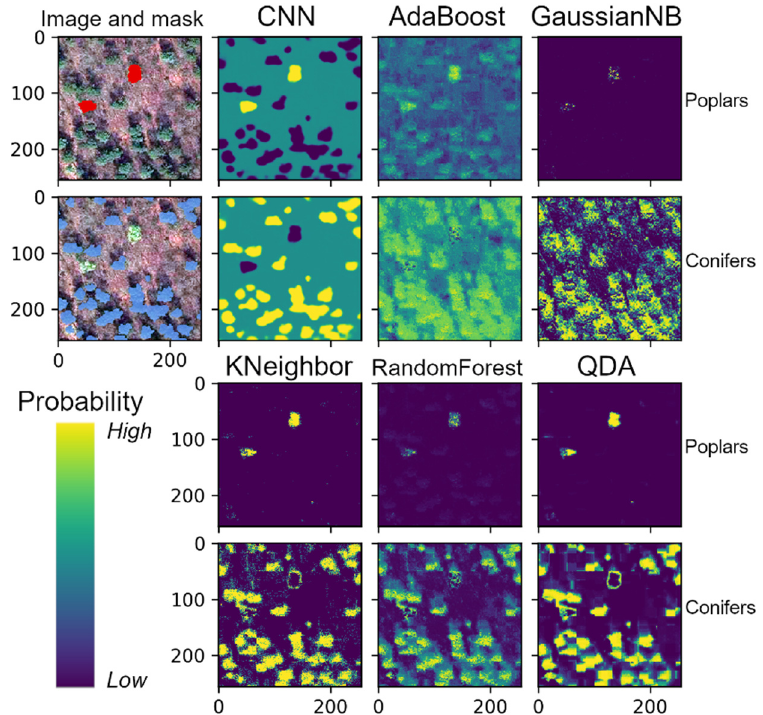
Figure 3. Comparison of pixel-based and U-Net-like CNN algorithm recognition results for 256 × 256-pixel images. The red color patches in the left images (Image and mask group) indicate masks for poplars, and the blue color patches indicate masks for coniferous trees. Segmentation algorithms: CNN—U-Net-like CNN; AdaBoost—adaptive boosting classifier; GaussianNB—naive Bayes classifier; RandomForest—random forest classifier; KNN— k -nearest neighbors classifier; QDA—quadratic discriminant analysis.